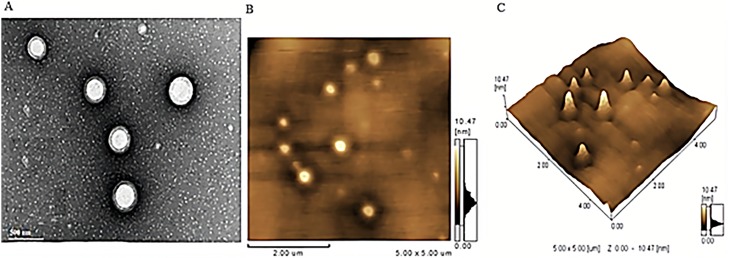
Morphological characterization of the optimized EELPH.Transmission electron micrograph (A), Atomic force micrograph planner view (B) and 3-D view (C) of EELPH. EELPH appeared as core-shell nanostructure with PS in consistency with DLS technique.